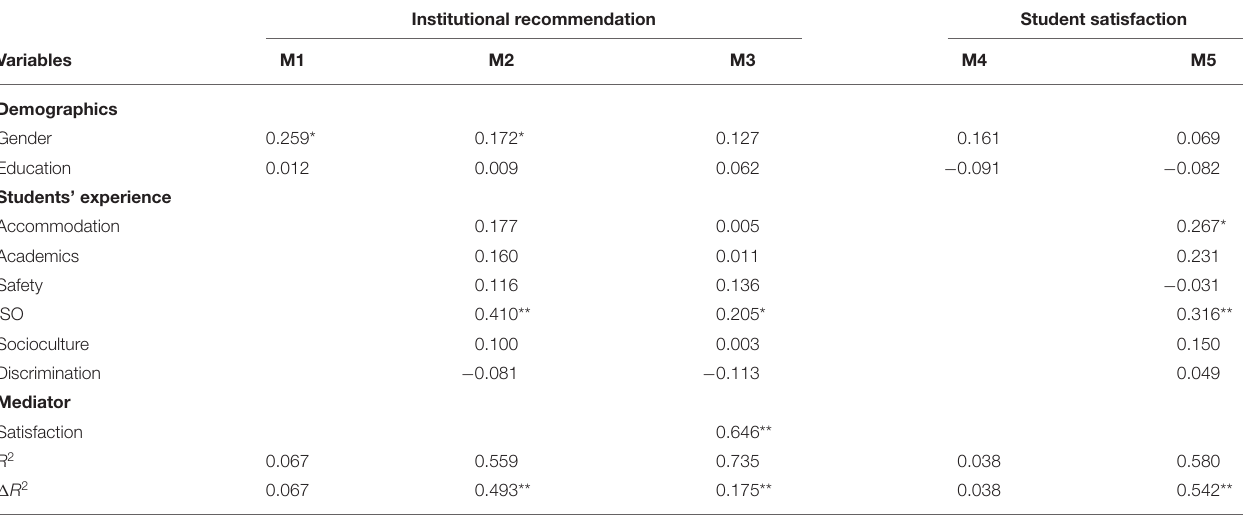
TABLE 6 | Results of the respondents from developed